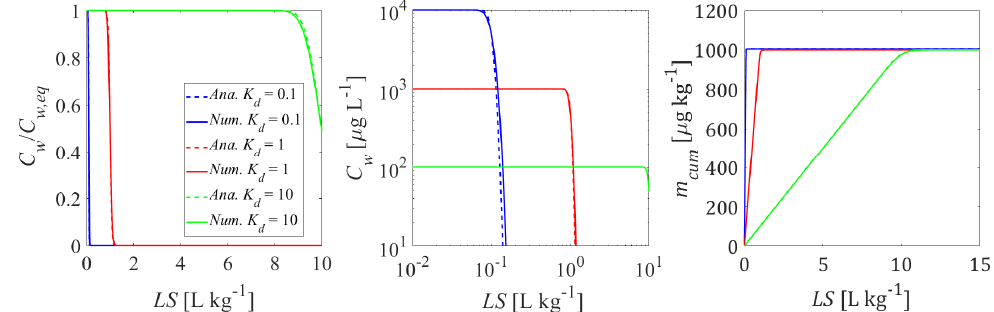
Figure A4. Normalized and absolute concentration ( C w / C w , eq , C w ) as well as cumulative concentration ( m cum ) in the column effluent vs. time (expressed as liquid to solid ratio: LS ) for initial conditions shown in Figure A3; comparison of analytical solution (Equation (6), dashed lines) and numerical solution (solid lines).